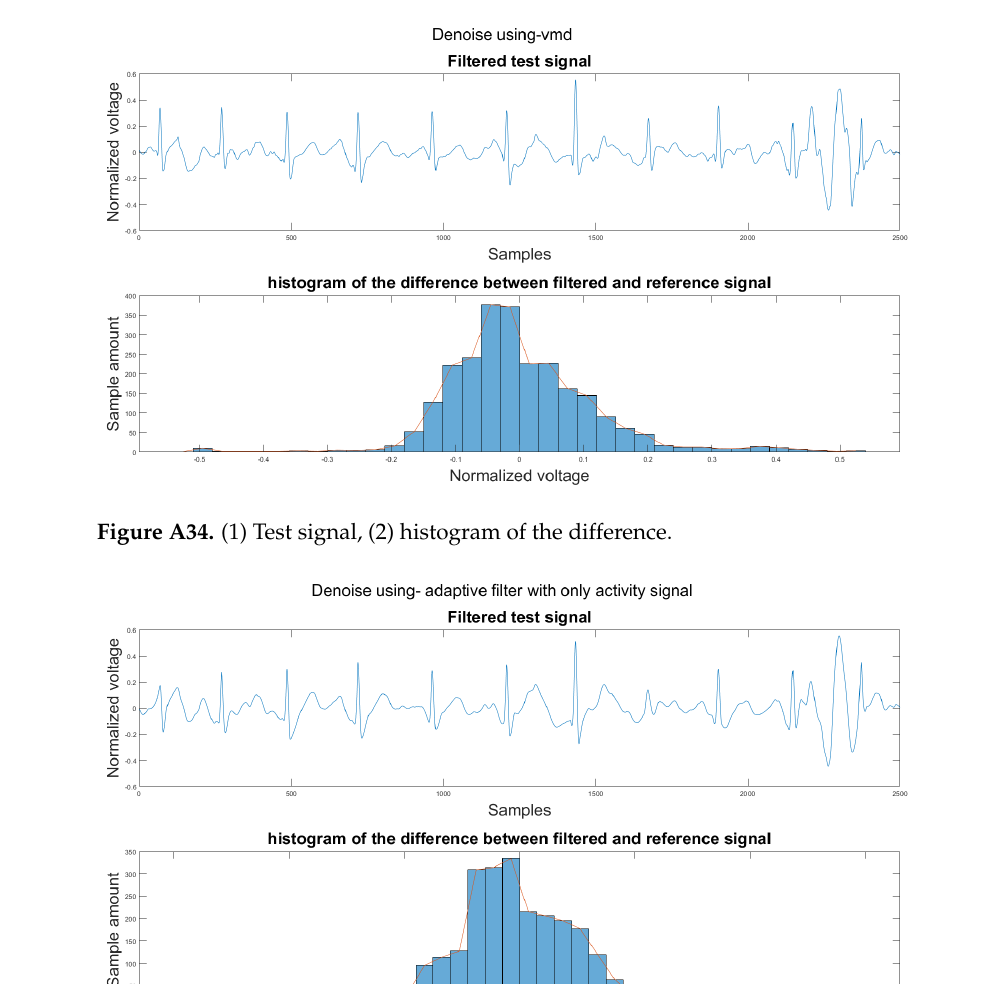
Figure A33. (1) Test signal, (2) histogram of the difference.